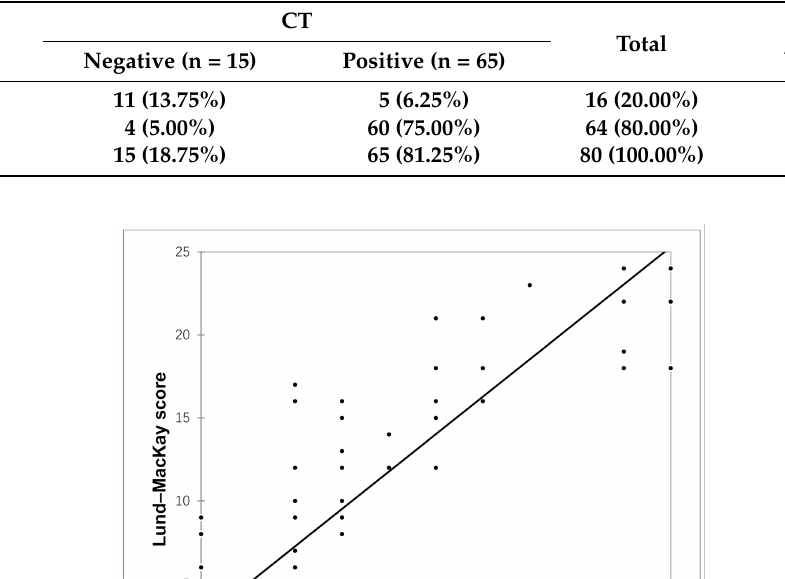
Table 4. Inter-rater kappa agreement between CT and endoscopy findings.